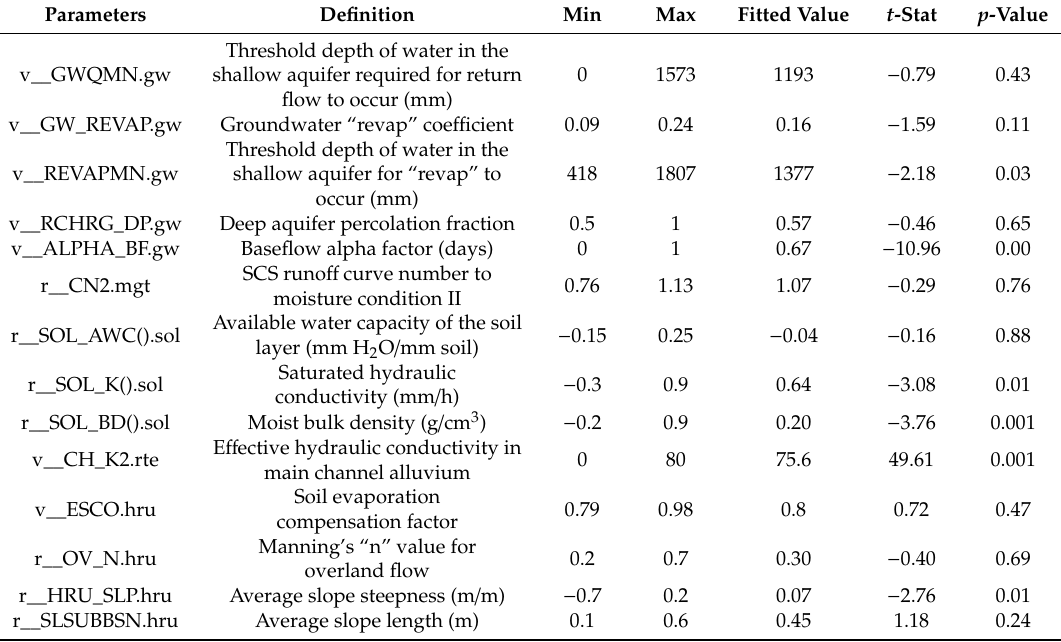
Table 3. Parameters used for SWAT model calibration, the hydrological model determination of the e ff ective parameters, and the sensitivity analysis in the Vakhsh River Basin, Central Asia.